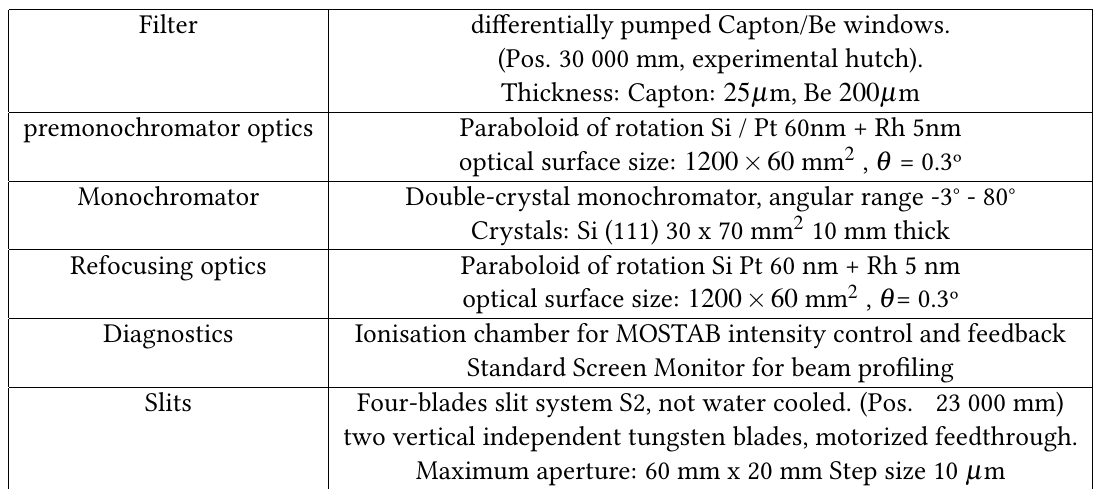
Table 2: Optical components and parameters of the KMC-3